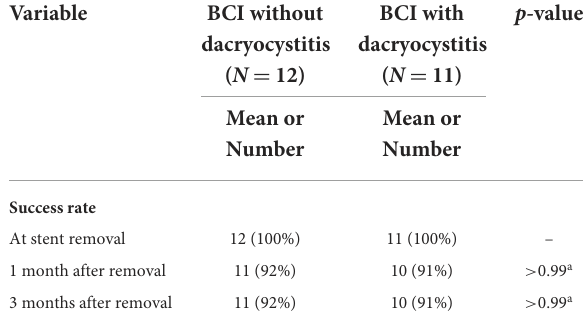
TABLE 5 Surgical outcomes of endoscopic DCR with BCI with or without previous